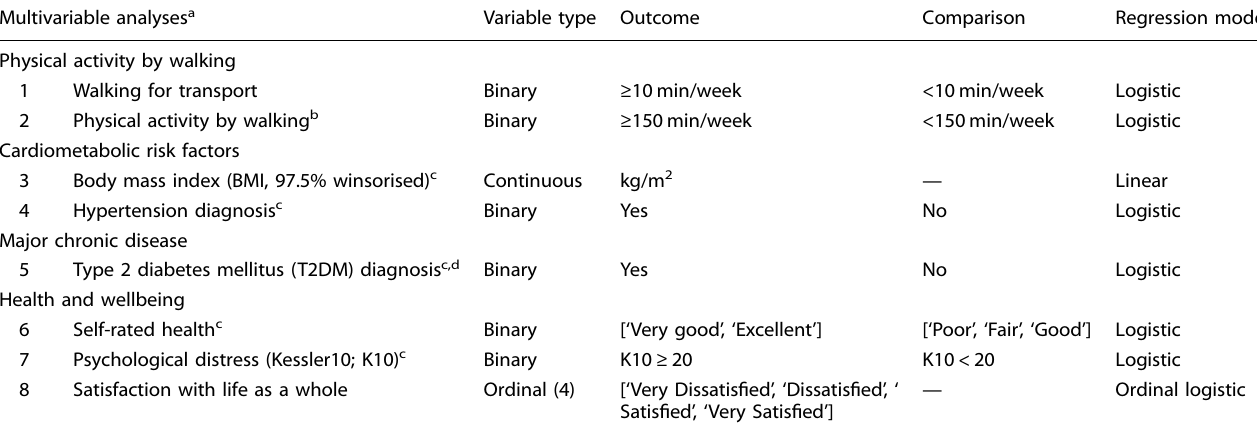
Table 6. Multivariable analyses conducted for built environment liveability exposures and health-related